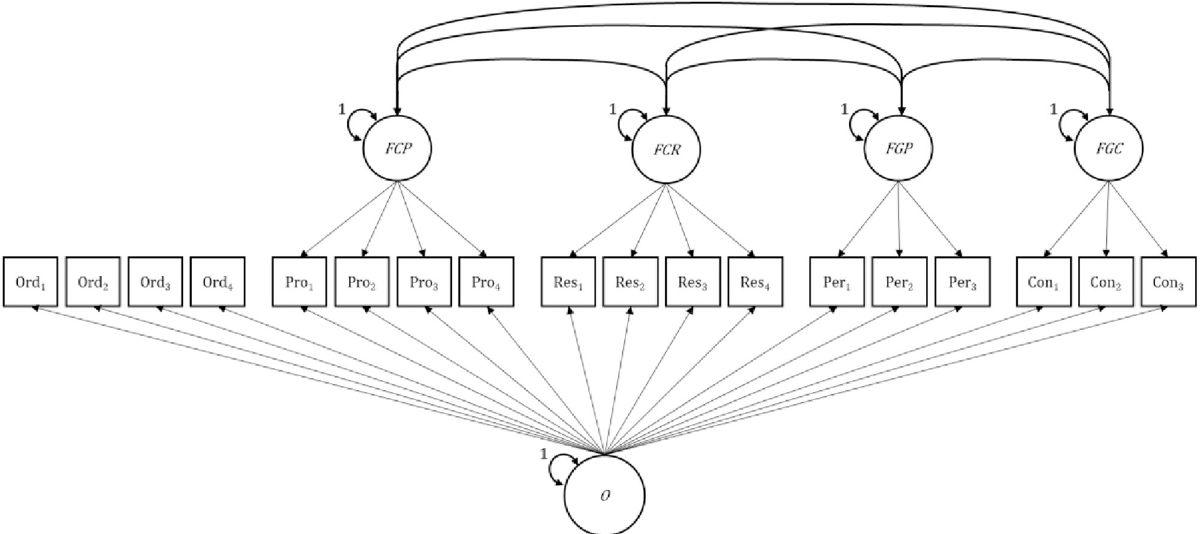
Fig 2. Bifactor-( S –1) model (Model B). O = Organization (Reference facet), FCP = specific Productiveness factor, FR = specific Responsibility factor, FGP = specific Perseverance factor, FGC = specific Consistency factor. Latent acquiescence response style variable not depicted.